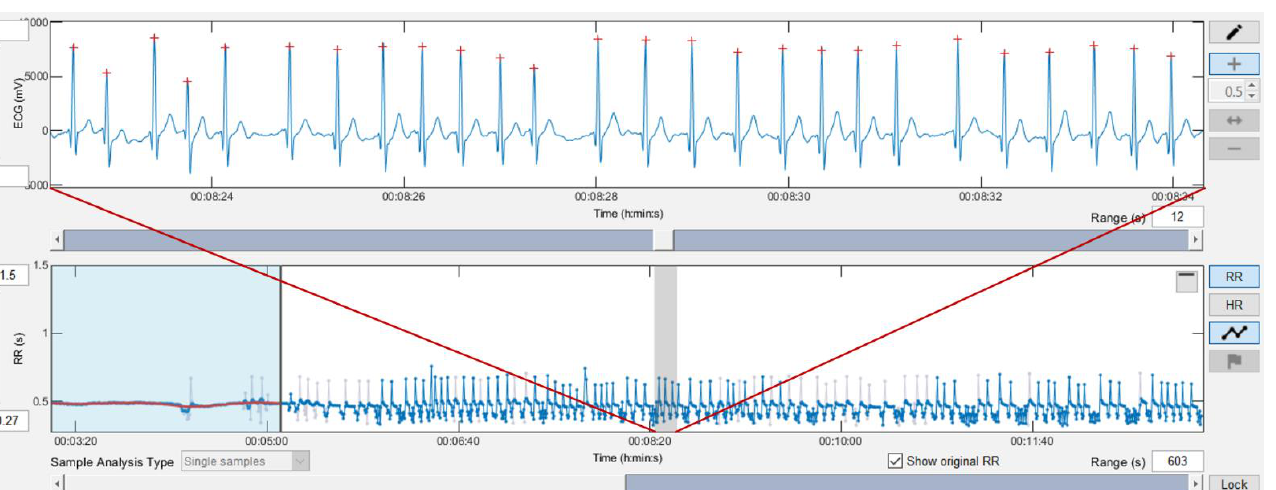
Figure 7. DFA a1 over time during an incremental cycling ramp until voluntary exhaustion with two participants wearing a 12 channel ECG, a Polar H10 chest belt, and a Movesense Medical sensor single channel ECG chest belt. ( A ): One participant with similar DFA a1 seen in both chest belt devices and lead 2 and lead V3 of the 12 channel ECG. ( B ): One participant with discrepancy between DFA a1 in both chest belt devices compared to lead 2 and V3 of the 12 channel ECG. All data were analyzed with Kubios HRV Premium software Version 3.5 (“time varying” option: window width of 2 min, grid interval of 5 s).